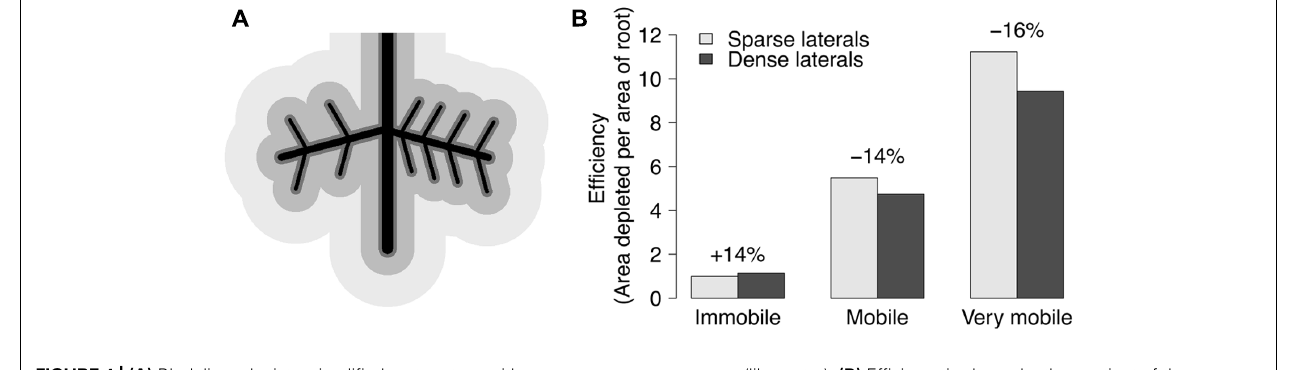
FIGURE 4 | (A) Black lines depict a simplified root system with a lateral root on each side of a tap root.The left side has 4 second order laterals, while the right side has 8 second order laterals.The darkest gray area around roots depicts the depletion zone of immobile resources (like P), while the medium gray depicts the depletion zone of mobile resources (like N), and the lightest gray represents very mobile